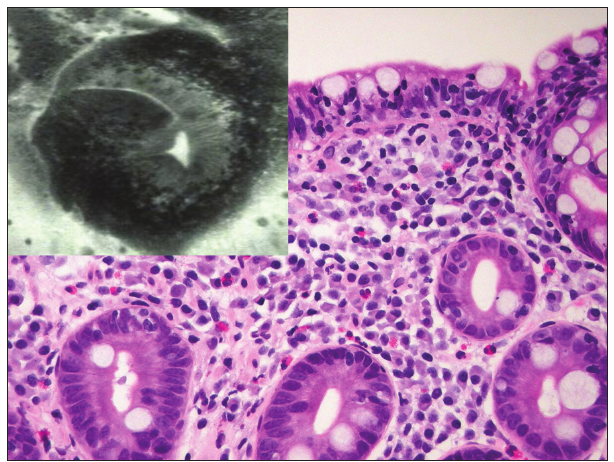
Figure 3) Confocal endomicroscopy images of normal duodenal mucosa. A Villi appear regular, ‘fingerlike’ with goblet cells between the entero- cytes. B Endomicroscopy especially highlights capillaries within the lamina propria